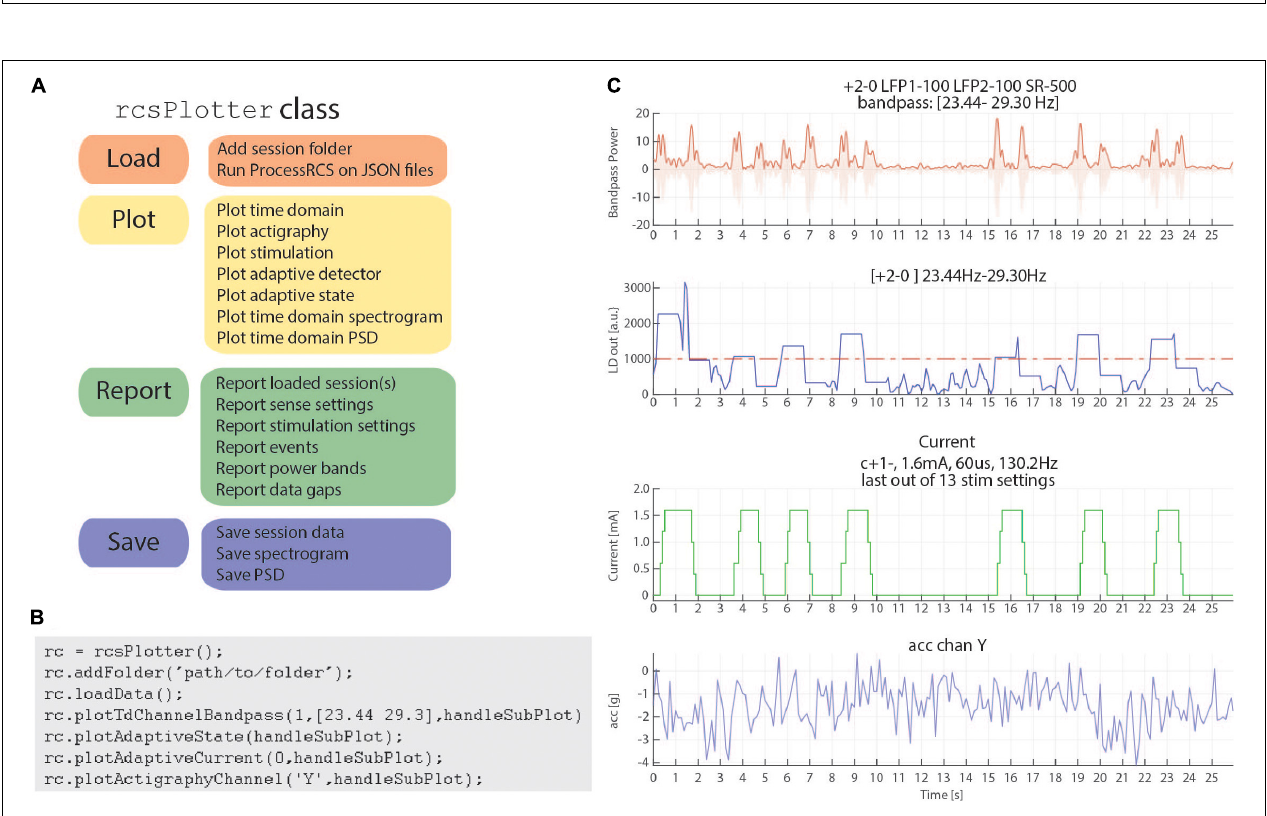
FIGURE 6 | rcsPlotter overview and example. (A) Main functions used in the “rcsPlotter” class. These functions are used for loading data which are processed through ProcessRCS.m, plotting all RC+S data streams, reporting values across recordings (such as stim state and event markers), and saving for downstream analyses. (B) Example function call for the “rcsPlotter.” This shows the simplicity of loading data from an embedded adaptive DBS session and plotting the results. Plots from function call show in panel (C) . Each stream has its own dedicated plotting command that will pull in meta data and display it in the subplot title. Adding additional folders (for example, from the same day) only requires one call (and will plot all streams together). There is a “plot” method for each data stream. A list of available methods is available in the function help section. (C) This output from the “rcsPlotter” class includes meta-data parameters pulled from multiple JSON files to populate graph titles. Top plot—bandpass time domain data used for embedded detector, sense channels and filter settings indicated. Second from top—output from embedded linear detector output (threshold shown as red dashed line). Third from top—stimulation current and current parameters. Bottom—actigraphy.